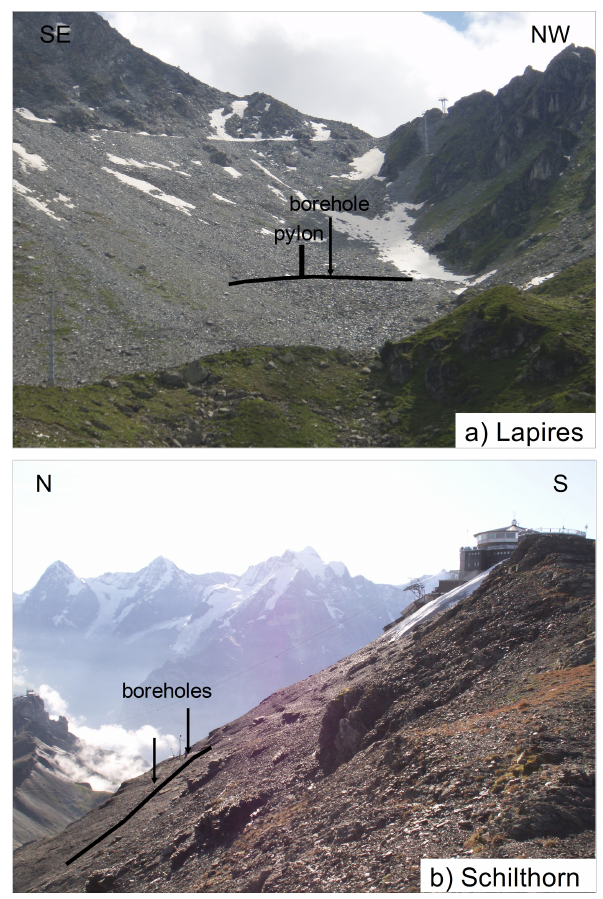
Fig. 2. Photographs of the test sites: (a) Lapires talus slope, and (b) the Schilthorn rock slope. The TLST profile lines and the posi- tions of the boreholes are